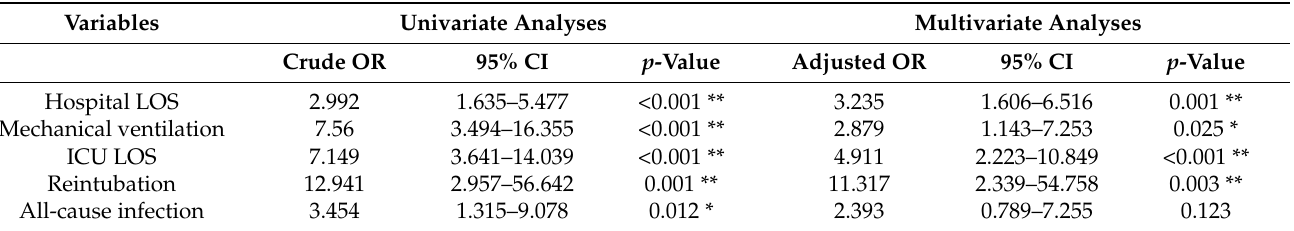
Table 2. Univariate and multivariate logistic analyses of risk factors associated with high ALT following TCPC